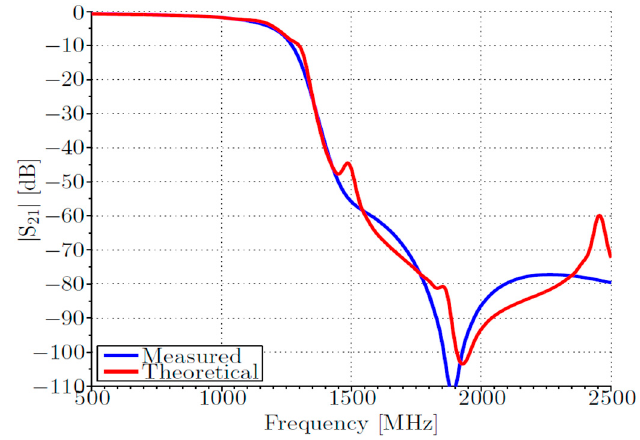
S response when two VLF-1200 low-pass filters are cascaded. Figure 6. Measured and theoretical | S 21 | response when two VLF-1200 low-pass filters are 21